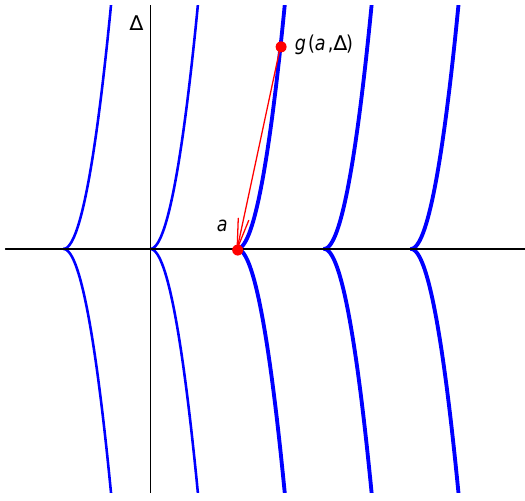
Figure 2. Plotting function g ( a , ∆ )